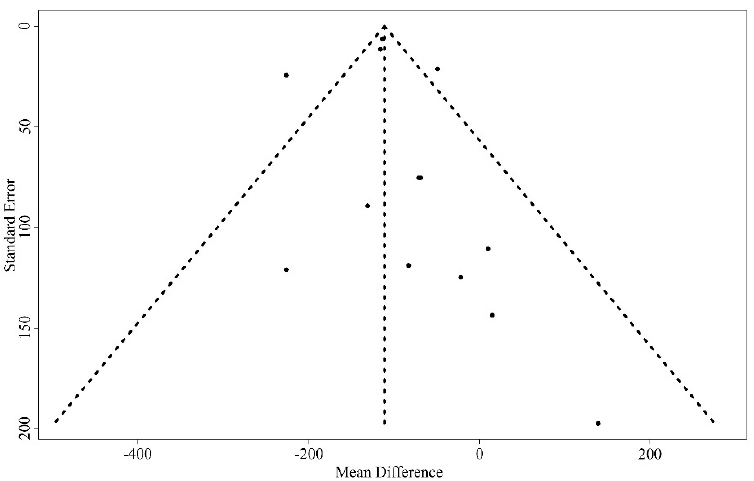
Figure A1. Funnel plot for random effects meta-analysis of mean difference in subsequent energy intake (kcal).